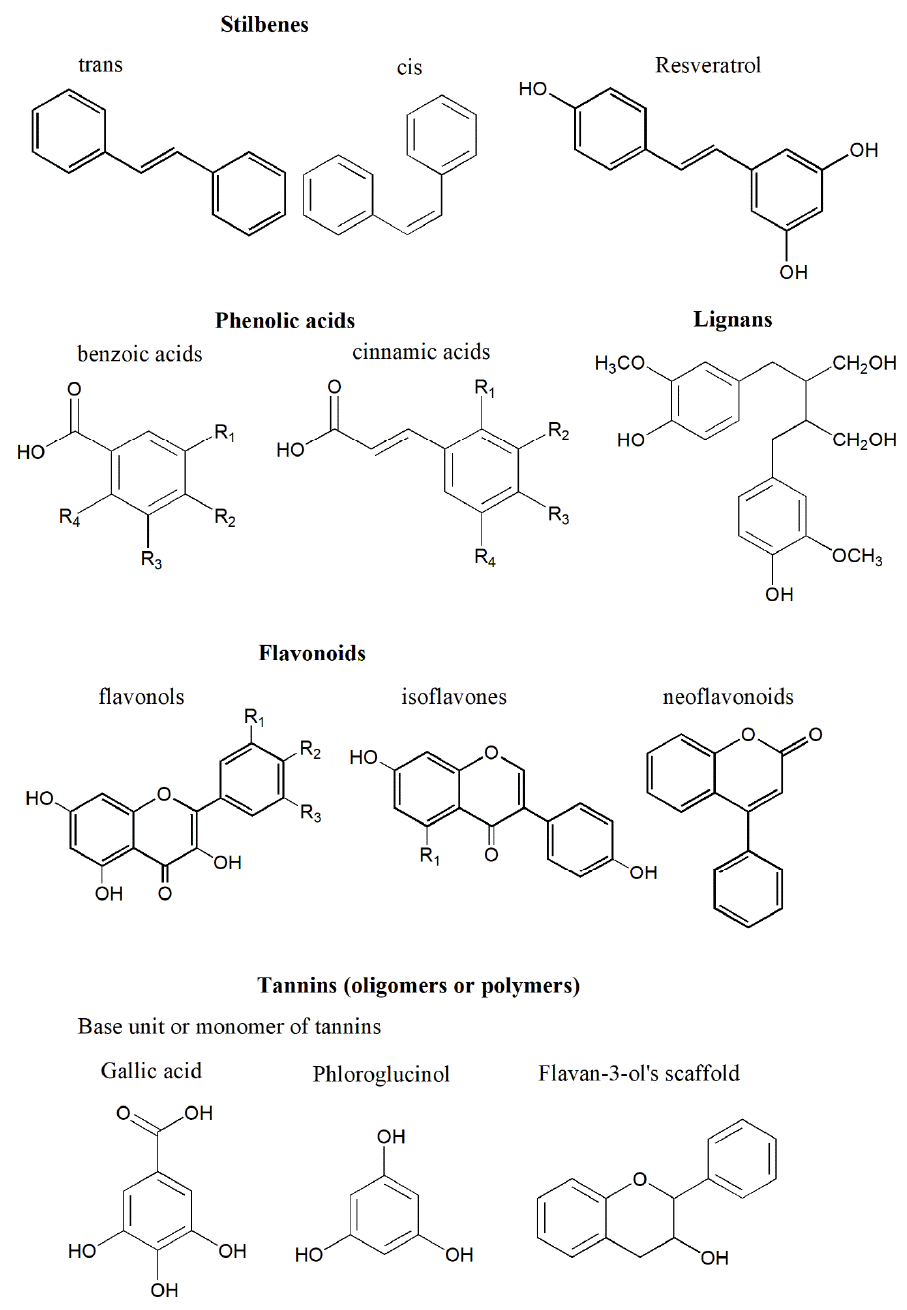
Figure 2. The chemical structures of polyphenols. Polyphenols are abundant phytochemicals in the human diet, with a great variety in molecular size and structure. These compounds are classified into different groups according to chemical structure, including the stilbenes (e.g., resveratrol), phenolic acids, flavonoids, tannins, and lignans.